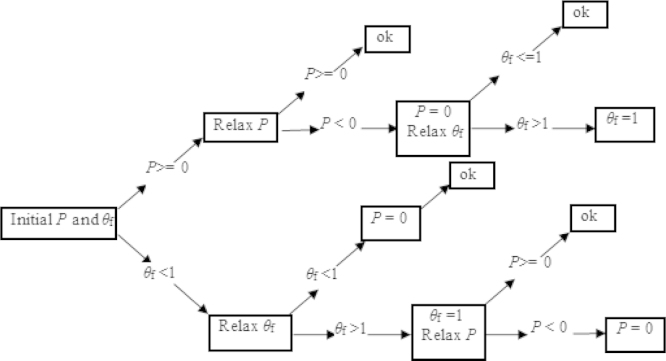
The flowchart of P and θf iteration.